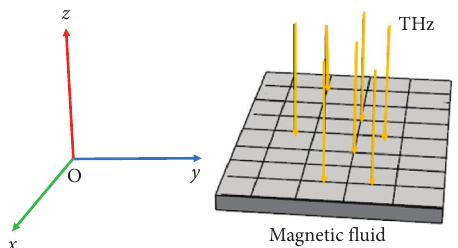
Figure 10: Magnetic fluid model of THz passing through an applied magnetic